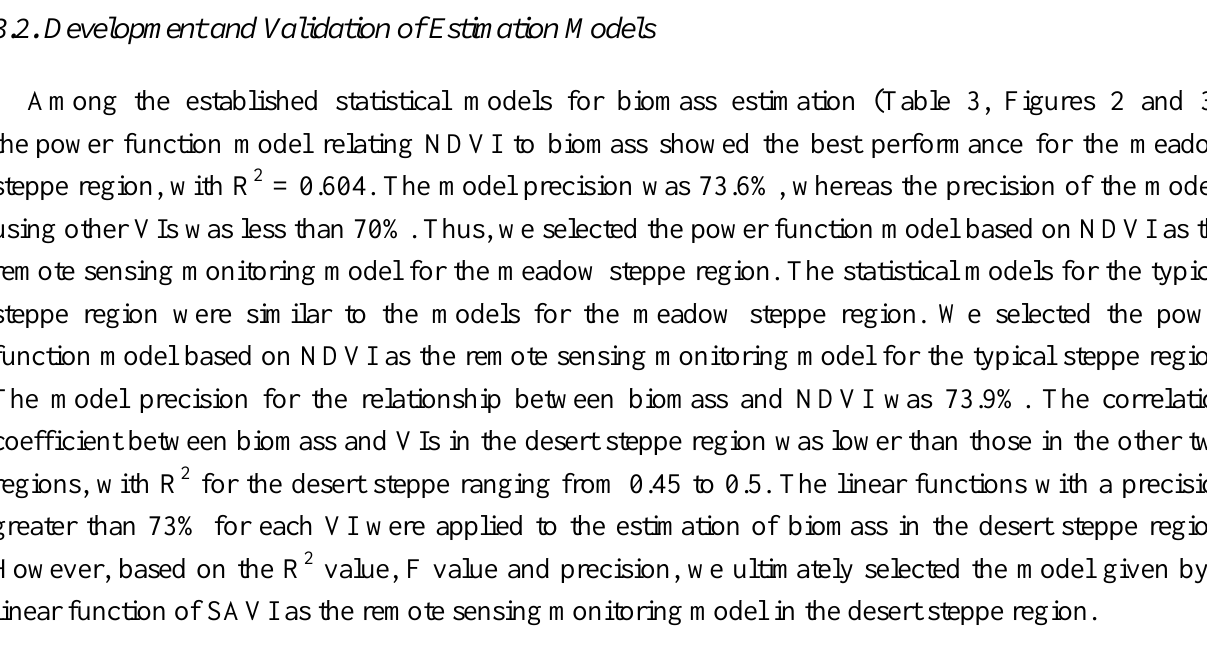
Table 3. Statistical models of the estimated biomass and precision for the three